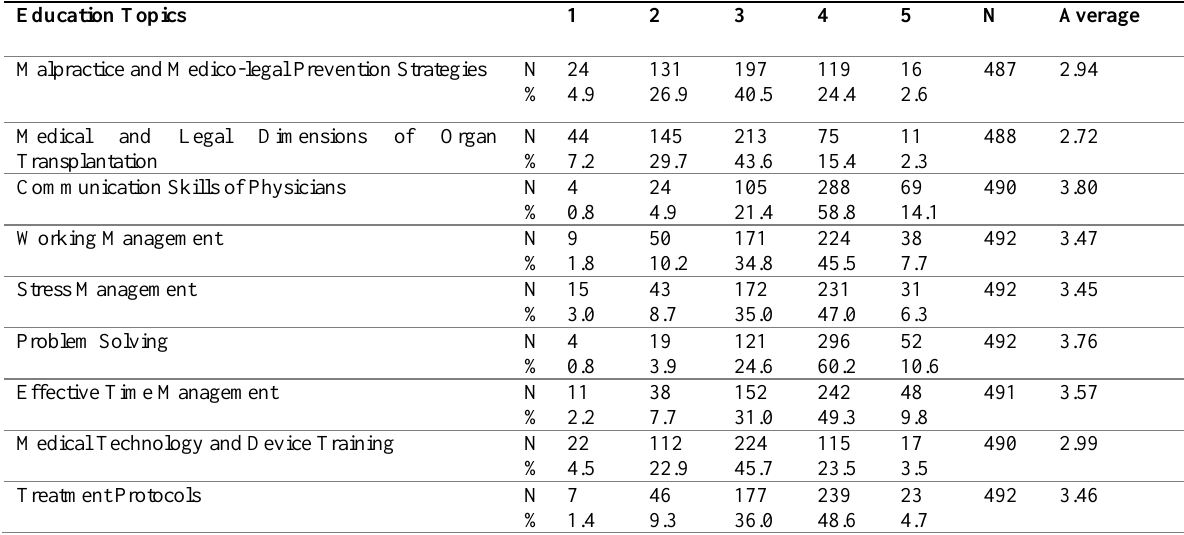
Table 25: Level of Professional Knowledge and Skills in Personal Development